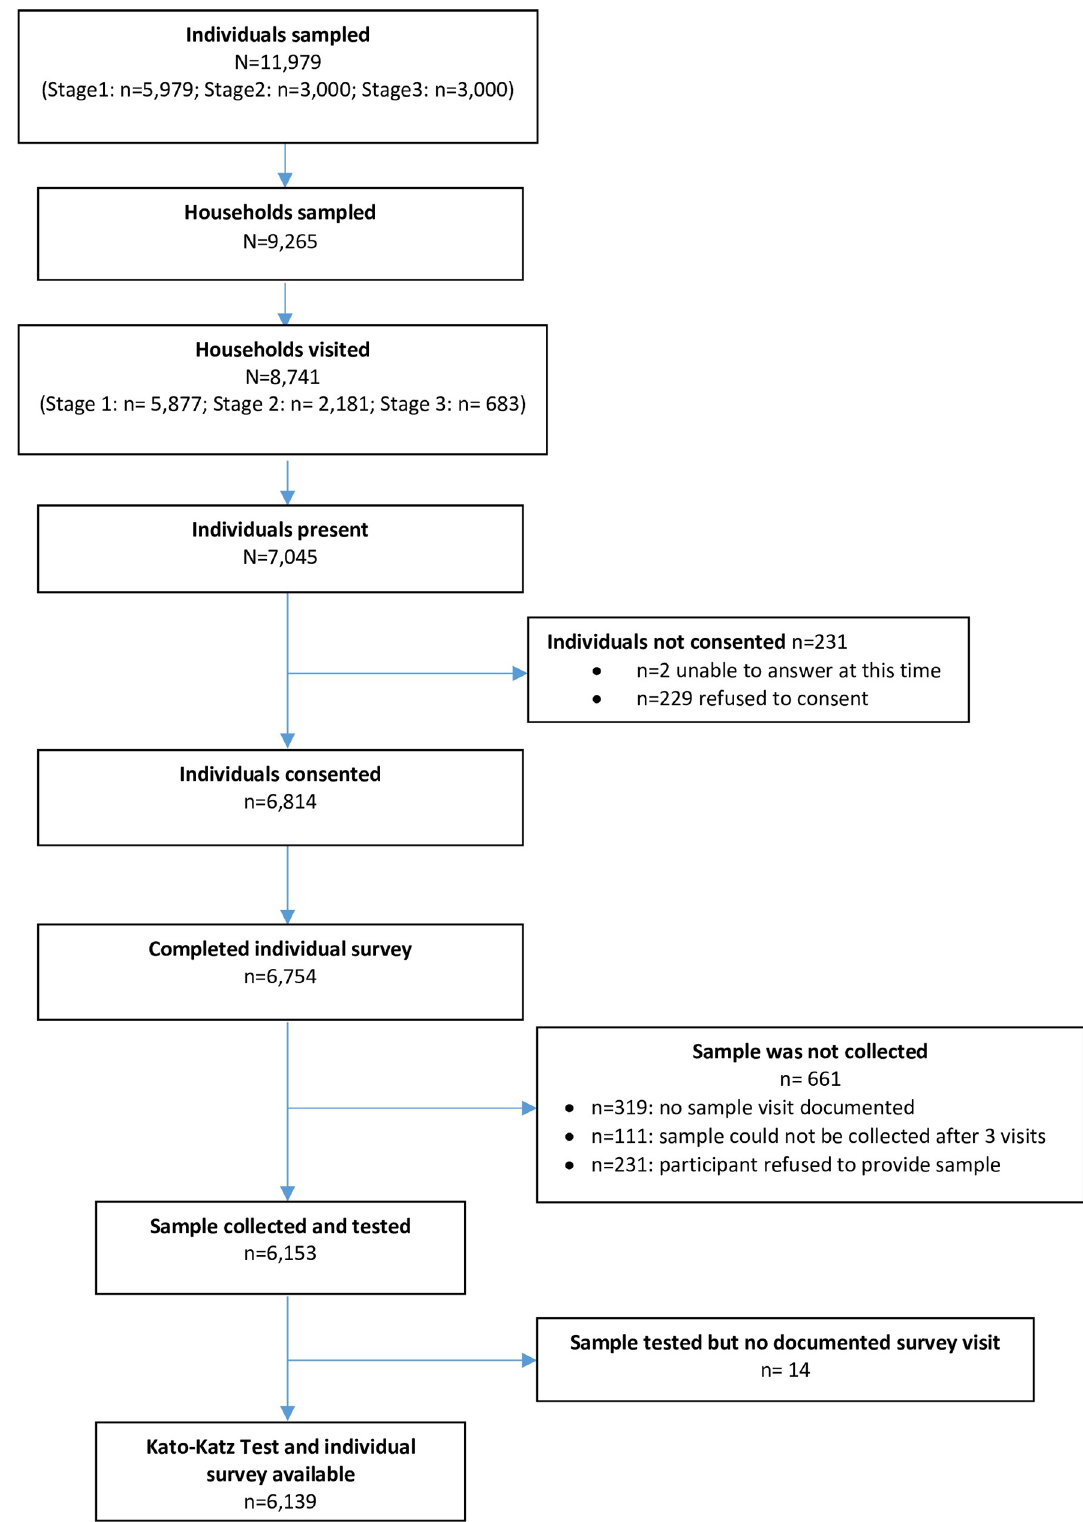
Fig 2. Flow diagram of stool sample collection for Benin site DeWorm3 baseline prevalence survey in Come´.